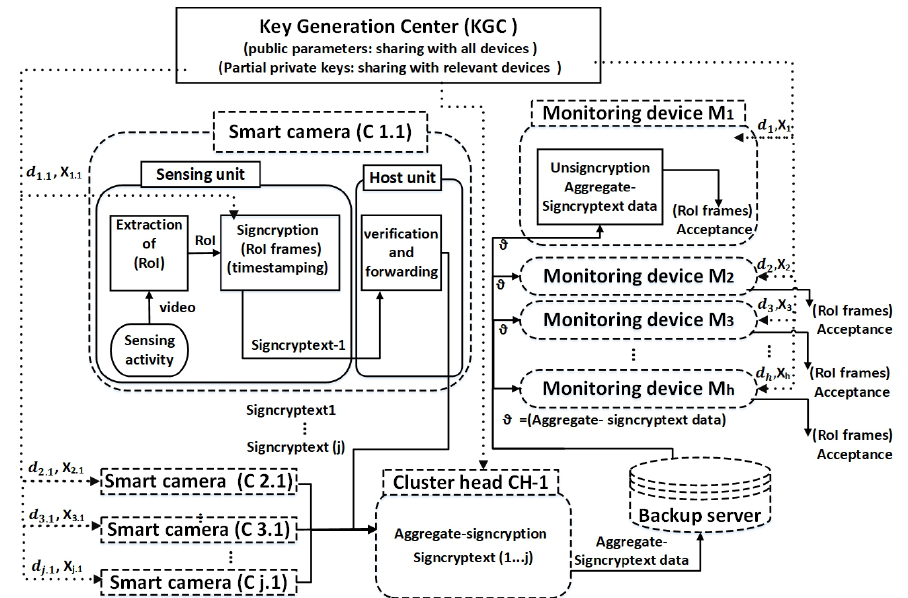
Figure 3. Operational phase depicting the processing flow of aggregate-signcryption for smart cameras in cluster i sending protected data to multiple monitoring devices (multi-receiver). The left side shows multi-cameras (sender devices) and right side shows the monitoring devices (multi-receiver). The distribution of keys and public parameters is shown by dotted lines, and the transfer of actual data is shown by solid lines, where d and X represent the partial keys and ϑ represents the aggregate-signcryptext data for multi-receiver (monitoring